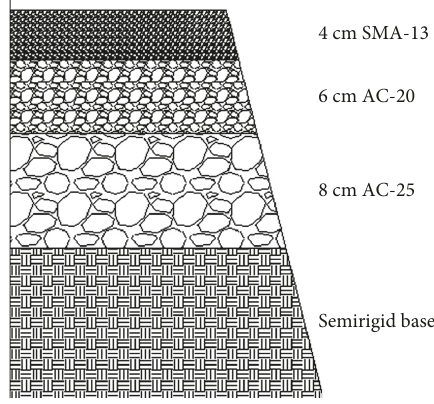
Figure 2: The pavement structure of asphalt